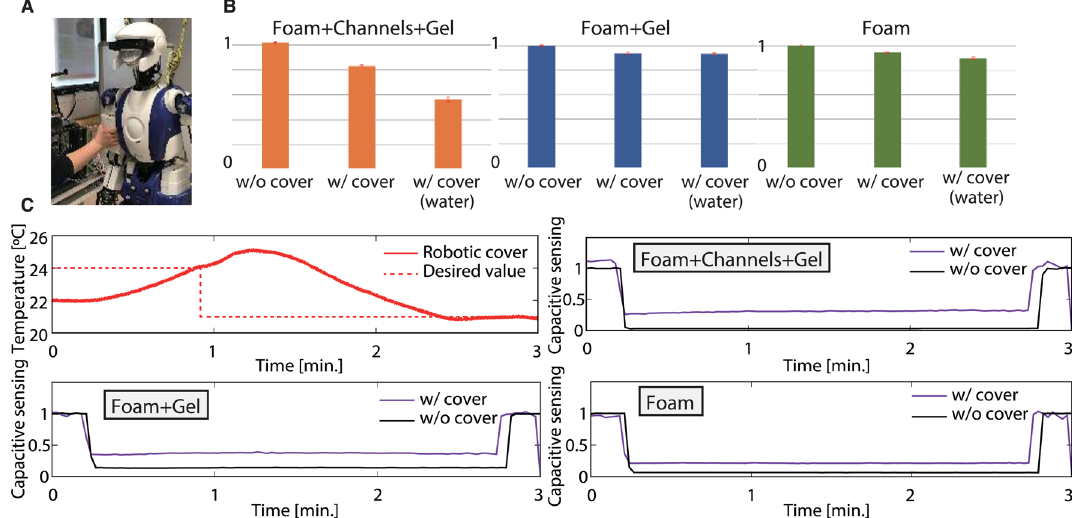
Figure 8. Concurrent thermal display and capacitive sensing. ( A ) We investigated the effect of the cover on humanoid’s capacitive sensing by grasping (full touch) the upper arm. ( B ) The capacitive sensor outputs were compared in three cases: (1) naked arm (without cover), (2) with the cover empty, and (3) with the cover filled with water. The three graphs show the average and the standard deviation (red line) of the capacitive sensor’s outputs recorded for 20 s without contact. Namely, the cover affects the capacitive sensing because the cover’s material itself and water are conductive. ( C ) We recalibrated after fitting the cover so that it does not affect the sensing. The outputs were monitored while heating and cooling the cover, grasping in 3 min except 20 s in the beginning and the end. These results suggest that our operating cover can be used concurrently with capacitive